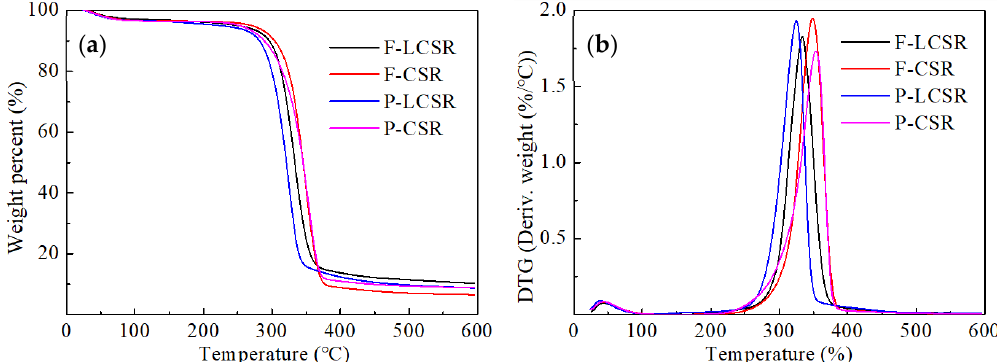
Figure 6. TGA ( a ) and DTG ( b ) for the samples from fibers and parenchyma cells.